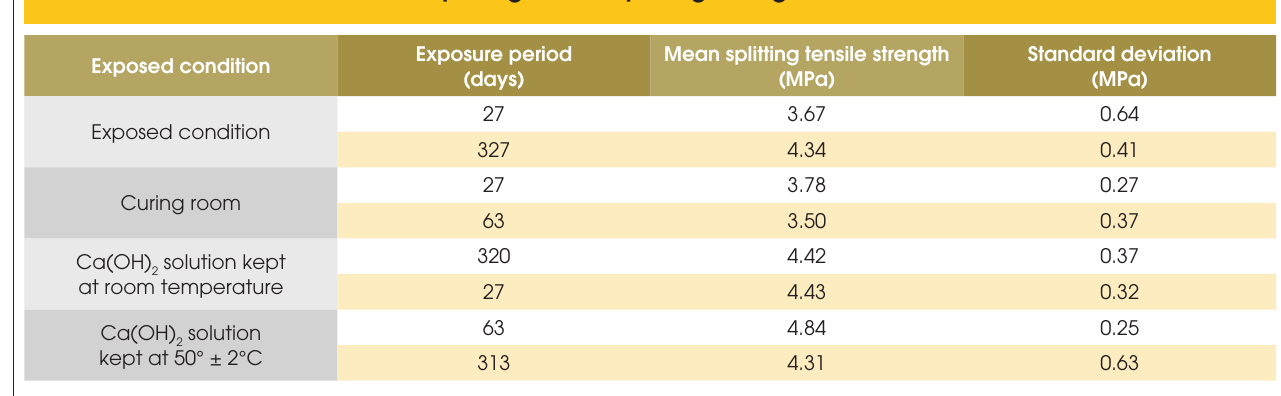
Table 2 – Splitting tensile splitting strength of the